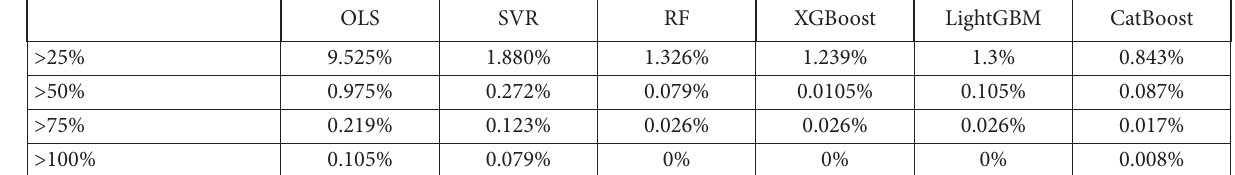
Table 12. Right-tail probability of absolute percentage error: single-algorithm predictors